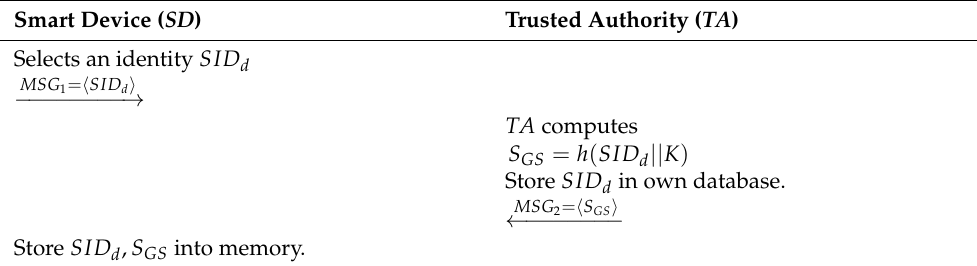
Table 2. Proposed smart device enrollment process. Smart Device ( SD ) Trusted Authority ( TA